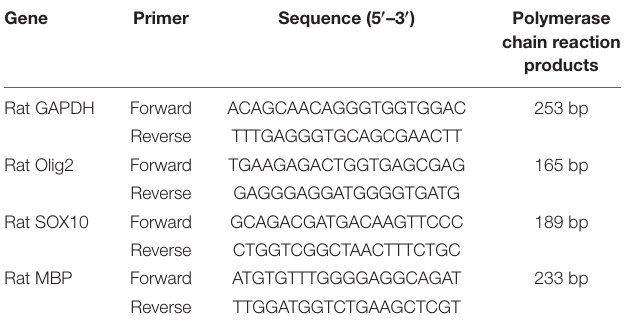
FIGURE 2 | Eye opening test in each group ( n = 6 in each group). The eye opening score was significantly delayed in the VPA group on PNDs 13 and 14. Compared with the control group: * p < 0.05.